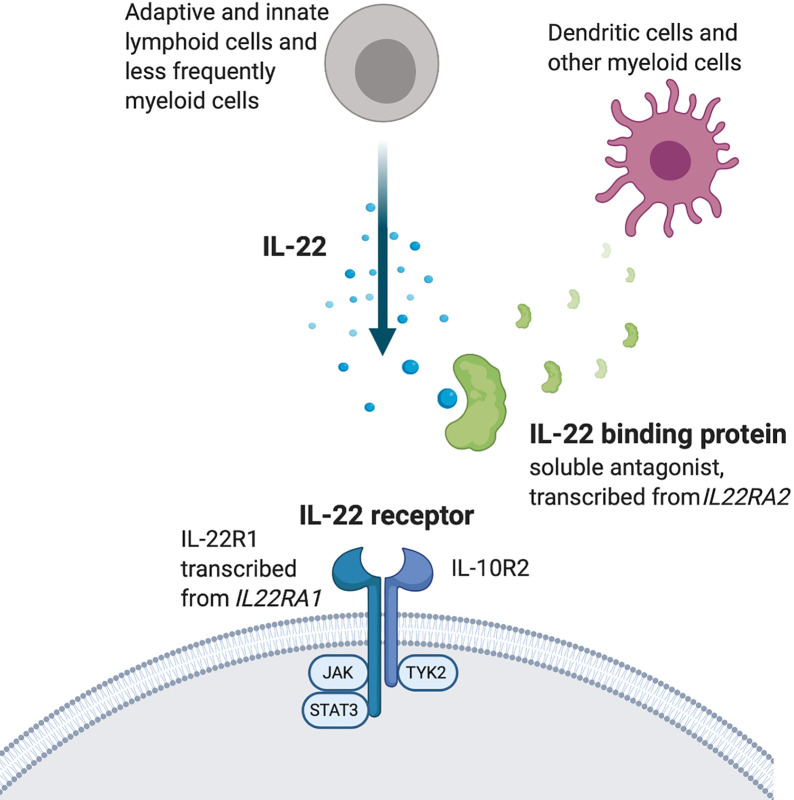
The IL-22 system.